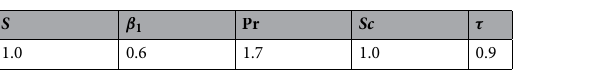
Table 2. Description of physical quantities, which are non-varying during the